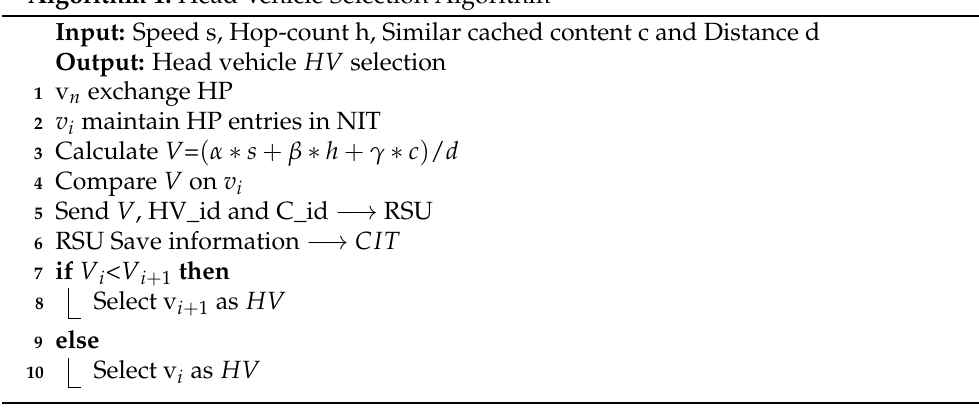
Algorithm 1: Head Vehicle Selection Algorithm